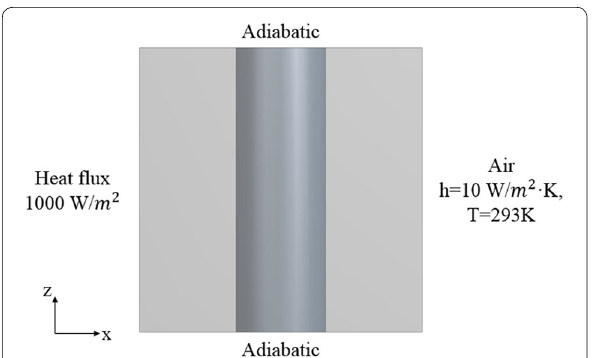
Fig. 6 Boundary conditions for the numerical simulations in reinforced